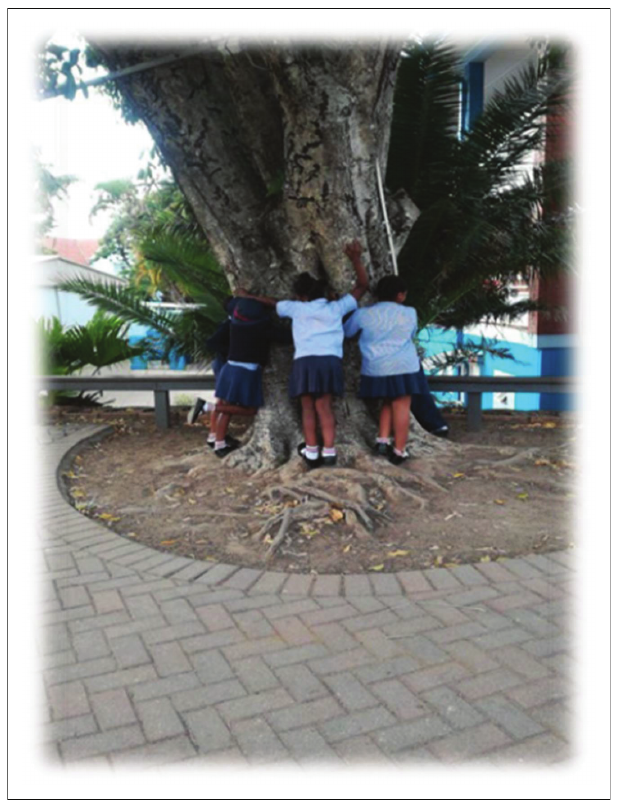
FIGURE 1: Graceful nature.